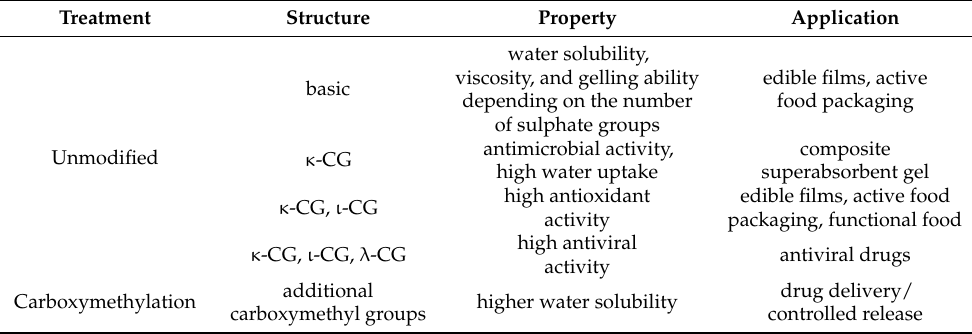
Table 2. The comparison of structure, properties and applications of unmodified and modi- fied carrageenans.